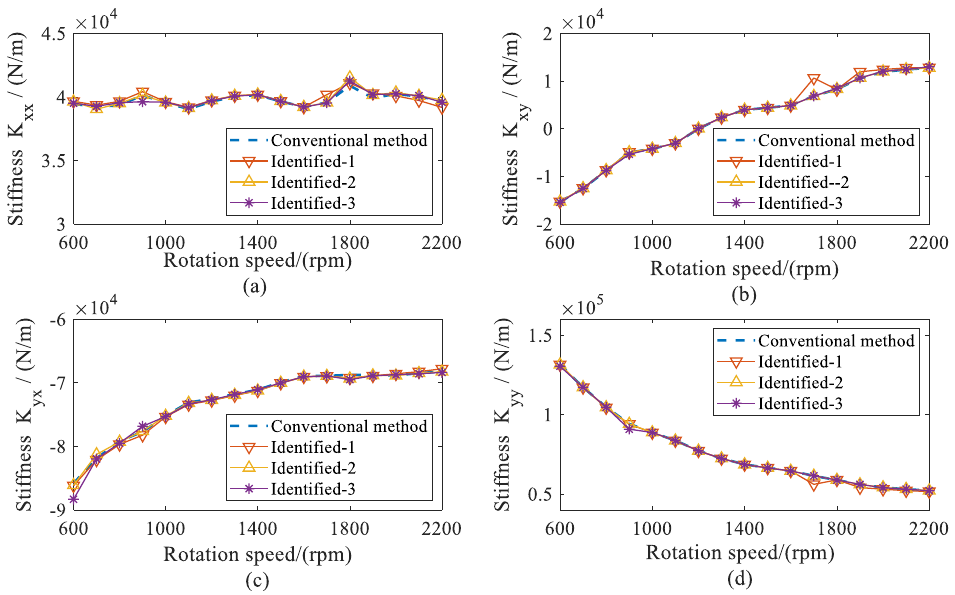
Figure 14. Comparison for stiffness coefficients of bearing 2 versus rotation speed. ( a ) direct stiffness coefficient K xx ; ( b ) cross-coupled stiffness coefficient K xy ; ( c ) cross-coupled stiffness coefficients K yx ; ( d ) direct stiffness coefficients K yy .